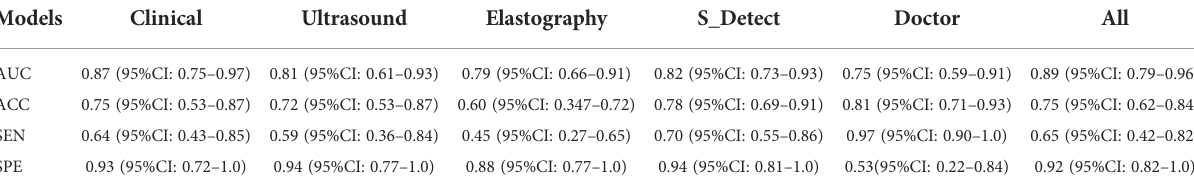
TABLE 2 The outcomes of different models to classify and predict benign and malignant breast nodules. Models